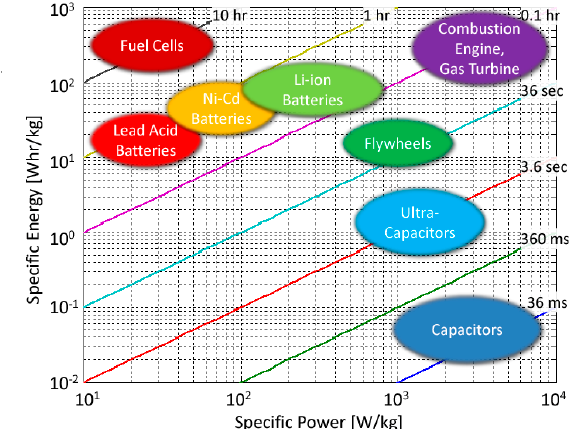
Figure 2. Ragone plot for the classification of energy storage devices with respect to their energy vs. power density (©2020 IEEE. Reprinted, with permission, from